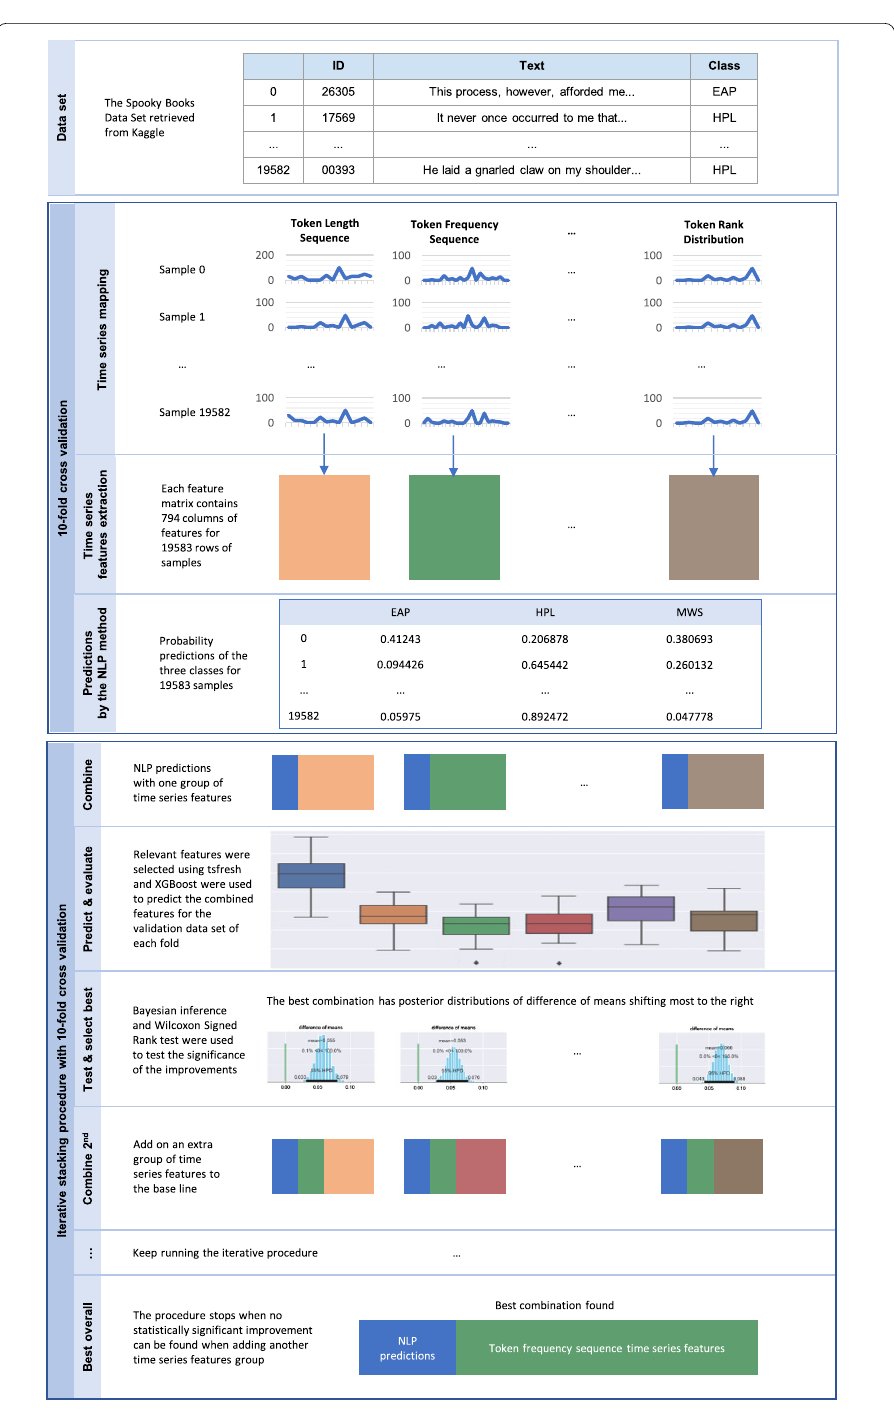
Figure 6 Evaluation procedure. The procedure involves retrieving the data set, creation of (fold-specific) functional language sequences, extracting, and selecting relevant time series features, obtaining NLP predictions, and identifying the best combination of time series features and NLP predictions